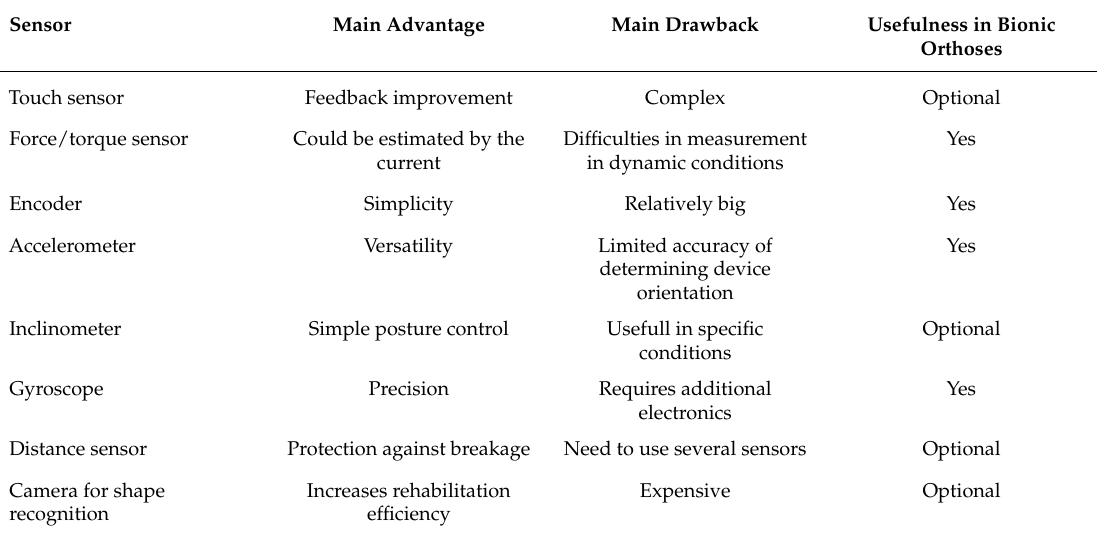
Table 4. Sensors used in bionic